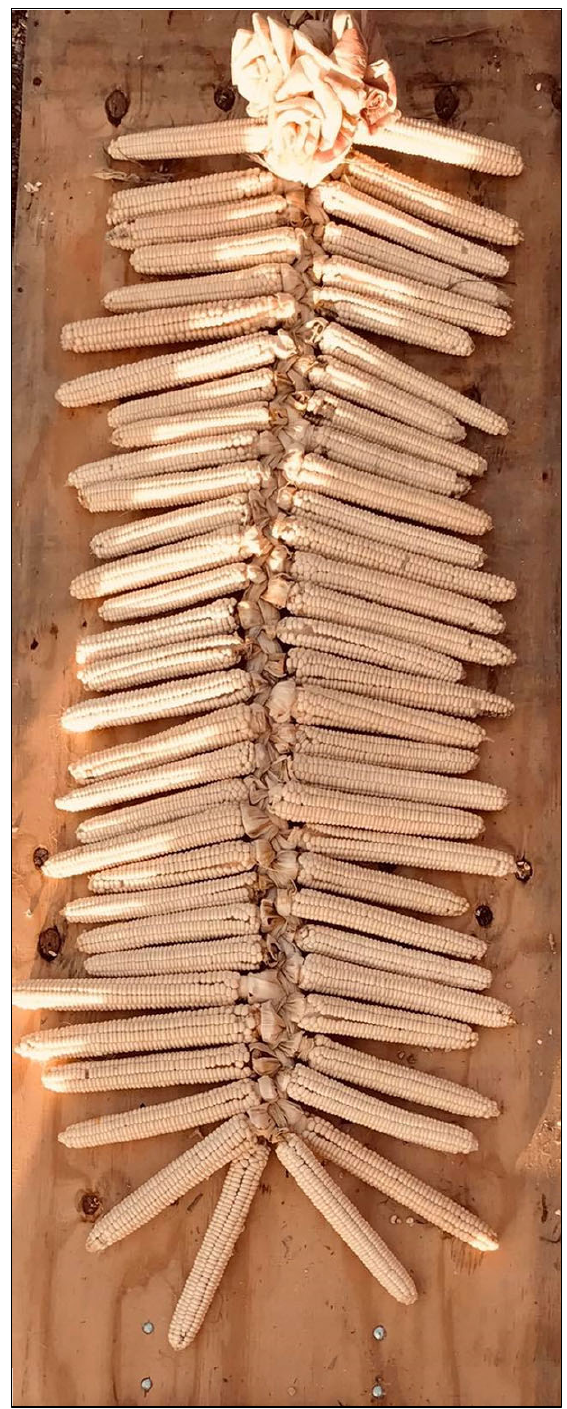
Photo courtesy of Rebecca